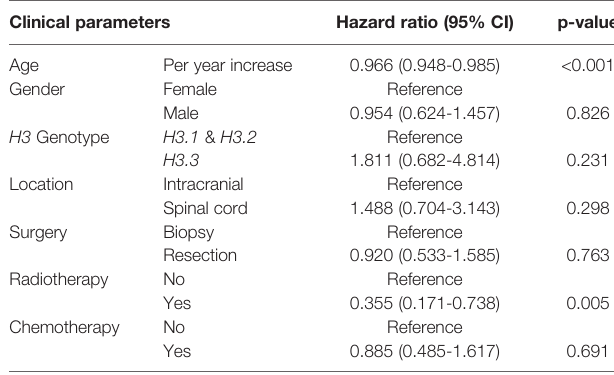
TABLE 2 | Multivariate Cox regression analysis for overall survival of H3 K27M- mutant midline